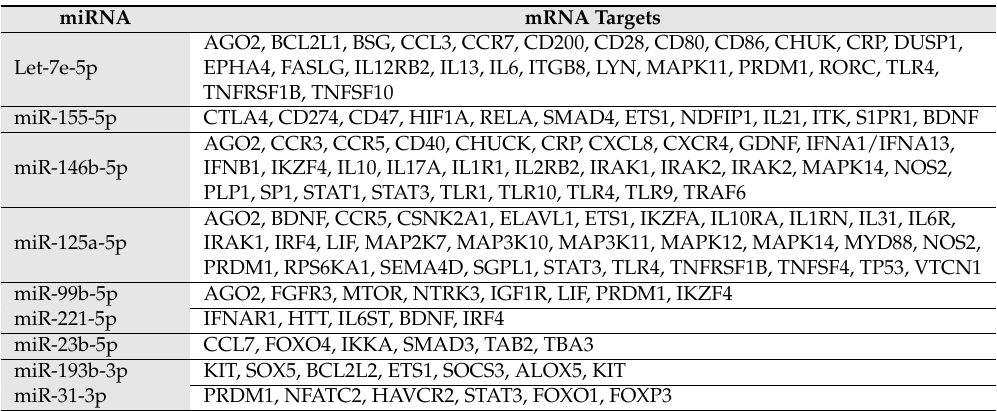
Table 1. The mRNA targets of select miRNAs altered during EAE development in mice.